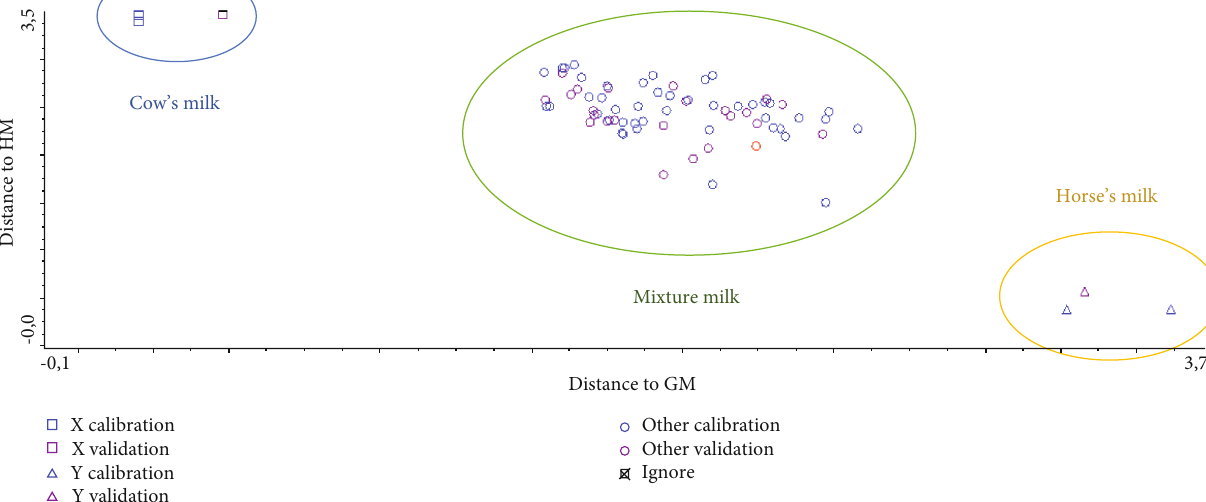
Figure 6: Cooman ’ s plot for discrimination between horse ’ s milk ( Δ ), cow ’ s milk ( □ ), and horse ’ s milk adulterated with cow ’ s milk